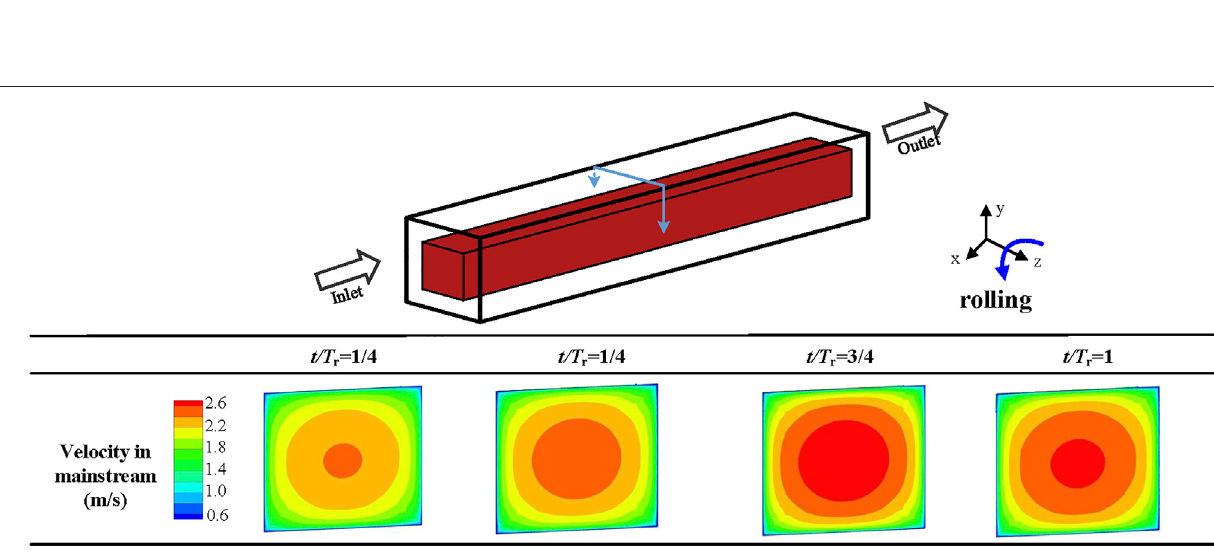
Frontiers in Energy Research |